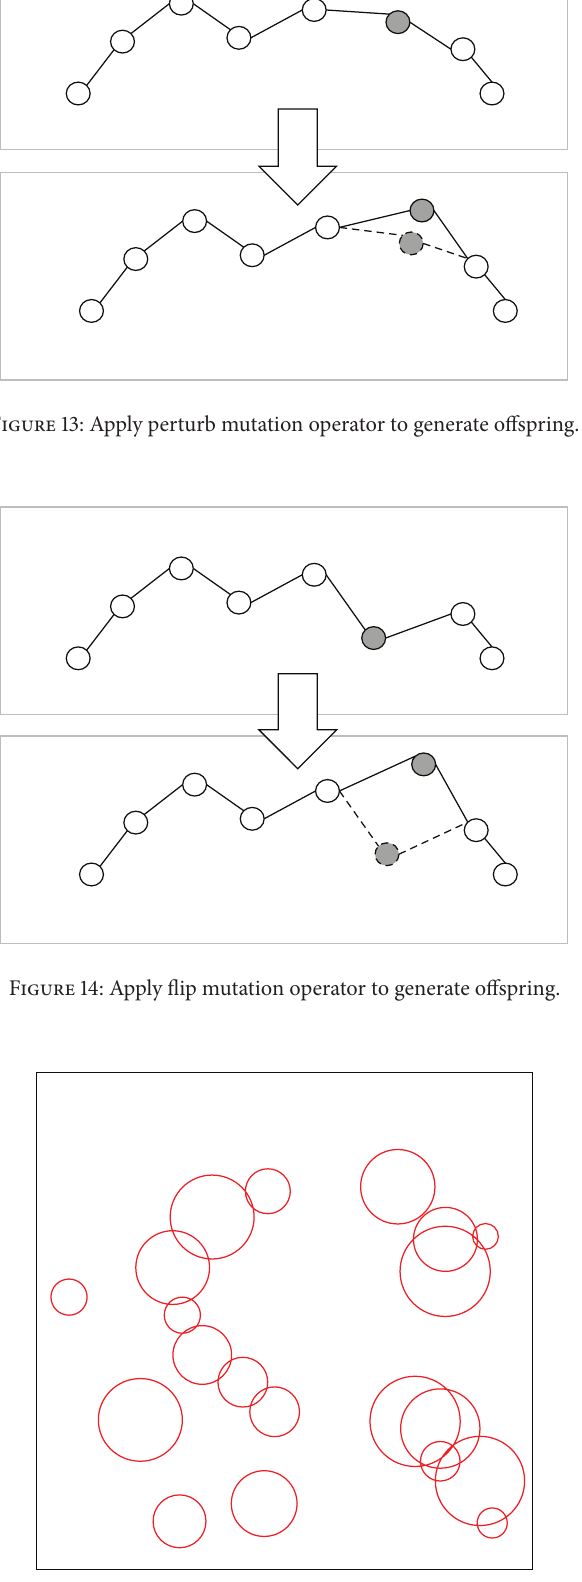
Figure 15: Test environment